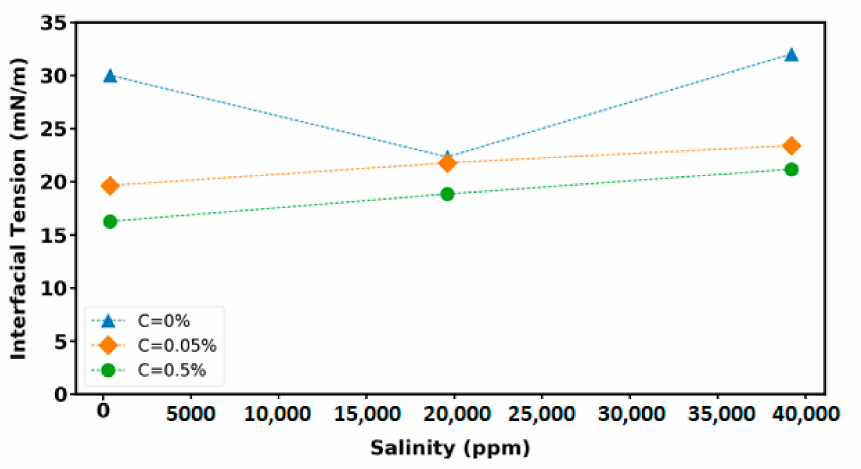
Figure 10. Interfacial tension (IFT) variations as a function of base fluid salinity and nanoparti- cle